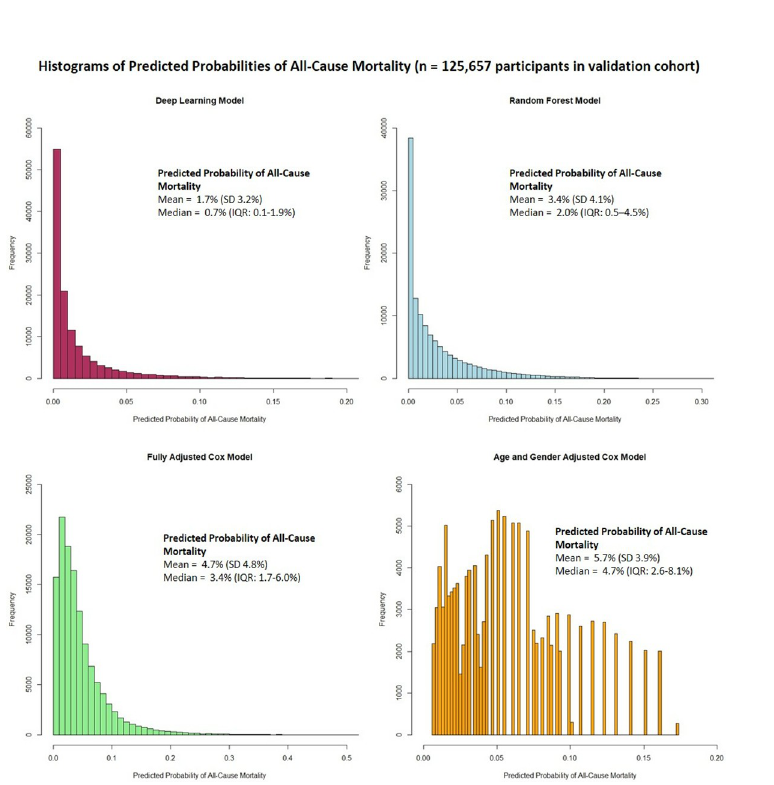
Fig 5. Distribution of predicted risks for all-cause mortality in the test cohort (n = 125,657).